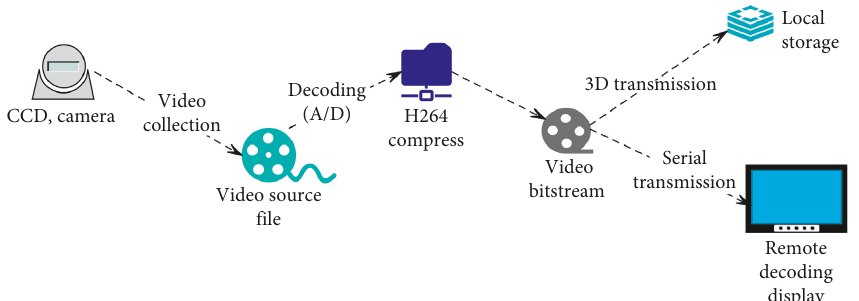
Figure 5: Flow chart of video file acquisition, decoding, compression, transmission, storage, encoding, and